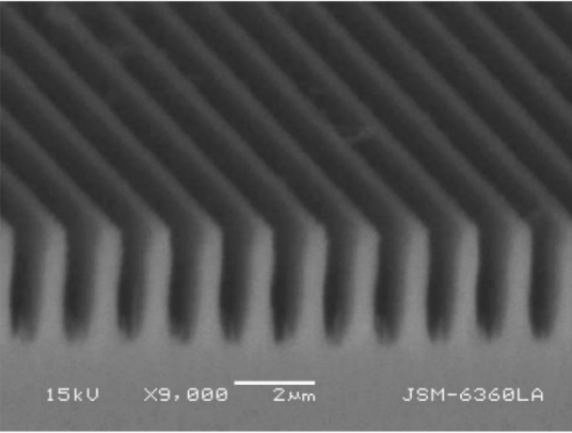
Figure 28. SEM image of the manufactured a dual-function transmission grating.